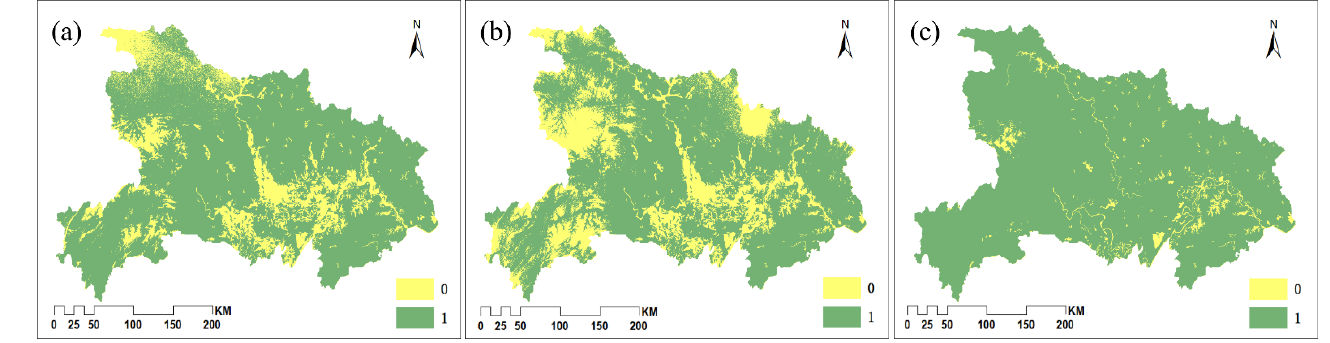
Figure 2. Preliminary screening of spatial suitability units of ( a ) Masson pine, ( b ) Chinese fir and ( c ) Chinese thuja.